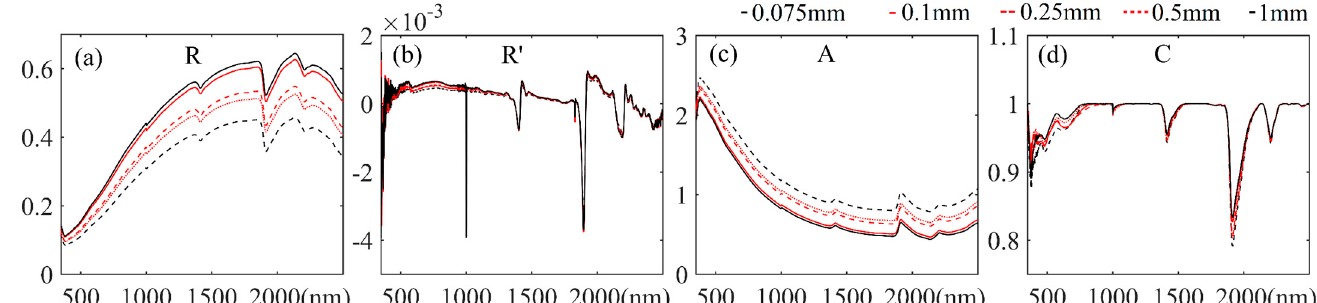
Figure 12. Average spectra of HLJ samples in soil particle size control experiments: ( a ) spectral reflectance (R); ( b ) the first derivative of the reflectance (R’); ( c ) the spectral absorbance (A); ( d ) the spectra of continuum removal (C).